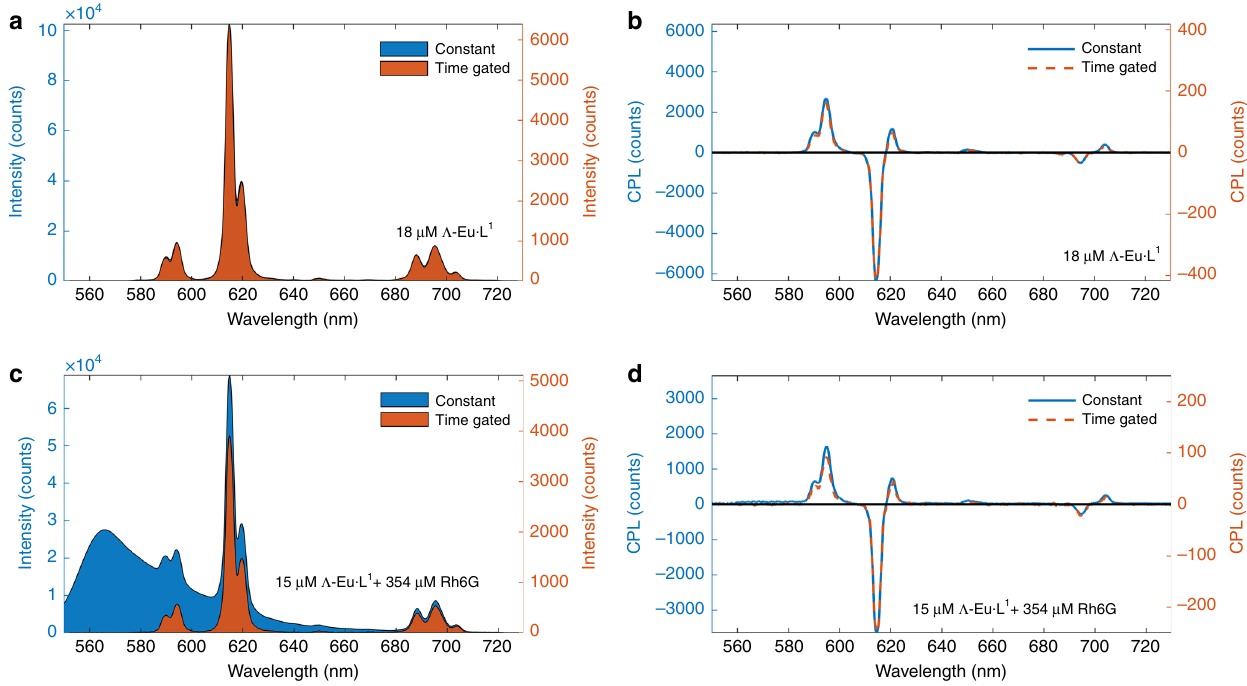
Fig. 3 Time-gated detection enables accurate recovery of total intensity and CPL spectra of long-lifetime lanthanide emission from ~18 µ M Λ -Eu·L 1 in a 50:50 solution of MeCN and MeOH Eu·L 1 ( τ ~ 800 µ s) in the presence of short-lifetime non-polarised fl uorescence emission of ~350 µ M Rh6G ( τ ~ 4 ns). a The total emission measured by both constant and time gated modes is equivalent when there is no background fl uorescence. b CPL of Λ -Eu·L 1 is recovered by both constant and time-gated modes is equivalent when there is no background fl uorescence. c Time-gating removes non-polarised fl uorescent background from measurements of total intensity. d CPL is correctly recovered by both constant and time-gated modes in the presence of non- circularly polarised background fl uorescence. Samples excited at 365 nm and spectra were recorded with standard scan settings. Note that the concentration of Λ -Eu·L 1 is slightly decreased from a , b to c , d due to